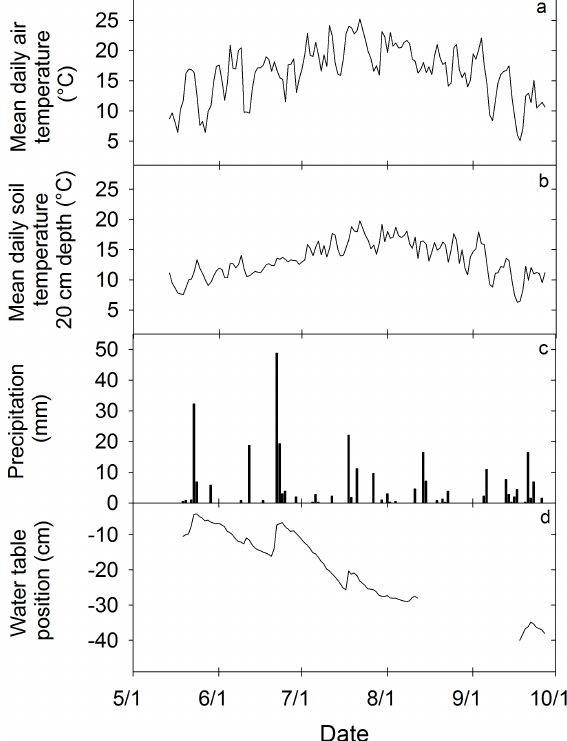
Fig. 1. Mean daily air temperature (a) , mean daily soil temperature (b) , precipitation (c) , and water table position relative to the surface (d) in a poor fen from 19 May to 27 September